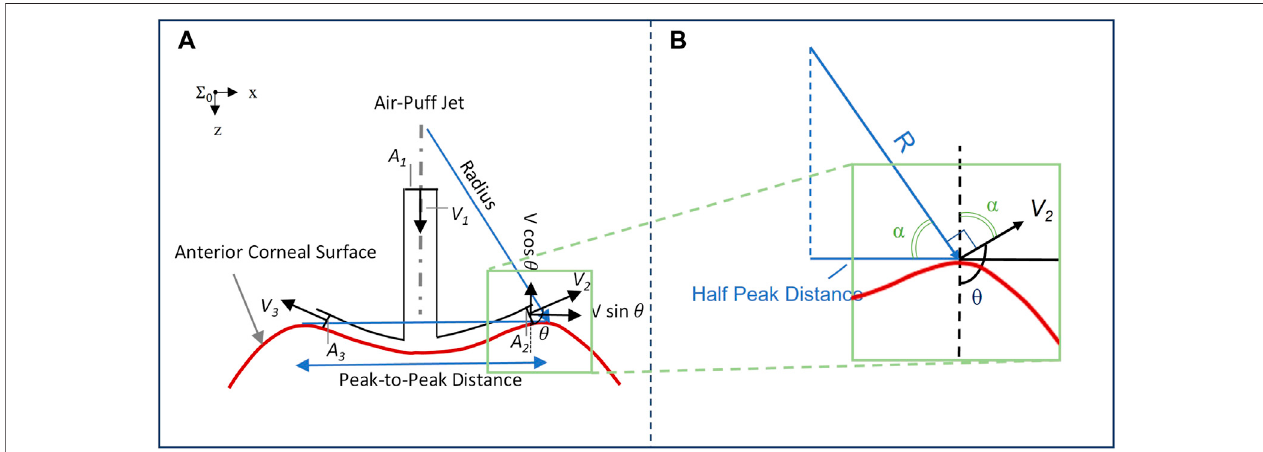
FIGURE 1 | (A) Impact of corneal surface shape on the load experienced post applanation, illustrated with a concave cornea. The inlet air fl ow velocity and cross- sectionalareaaredenotedbyV